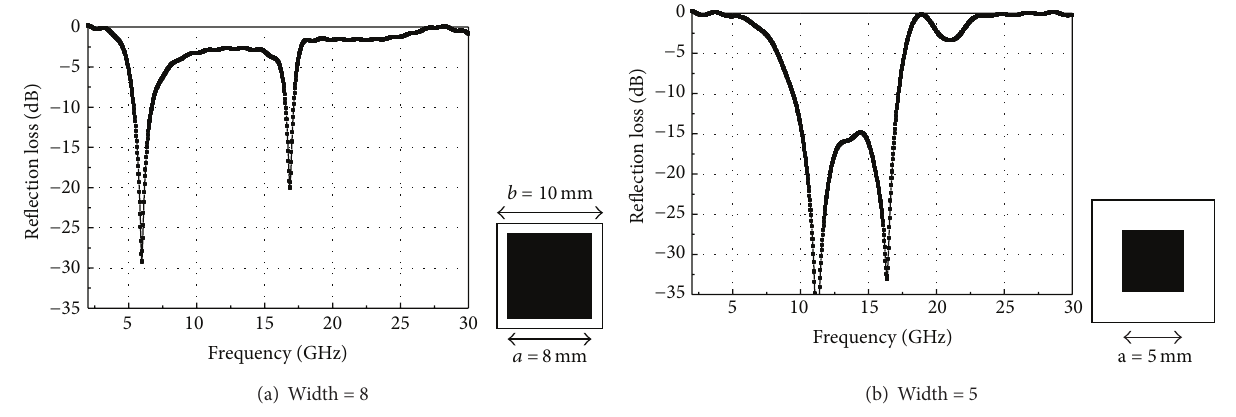
Figure 3: Peak control: AMC absorber with Salisbury